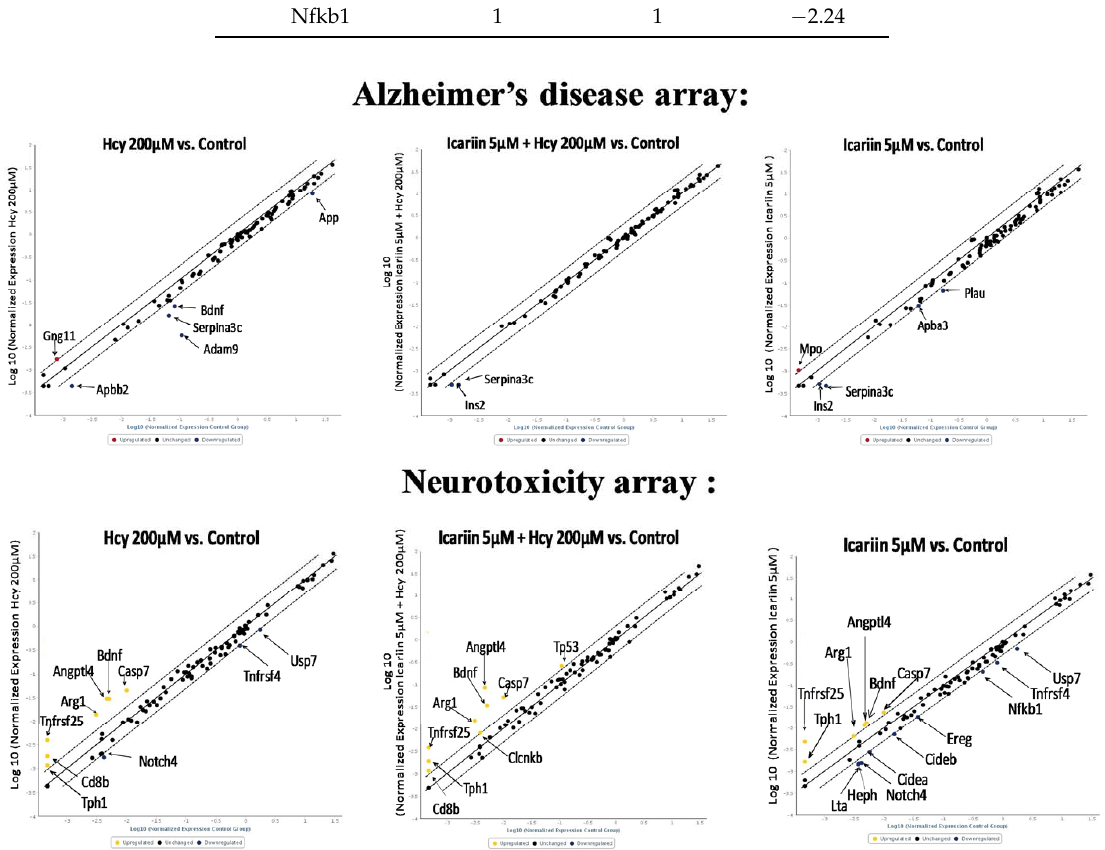
Figure 6. The scatter plots of AD array and the neurotoxicity array. cDNAs were prepared from Hcy, icariin, Icariin + Hcy and the control groups and each cDNA sample was applied for AD and neurotoxicity arrays. The scatter plots of each treatment groups were generated by normalized against the control according the Qiagen online data analysis for RT 2 Profile PCR